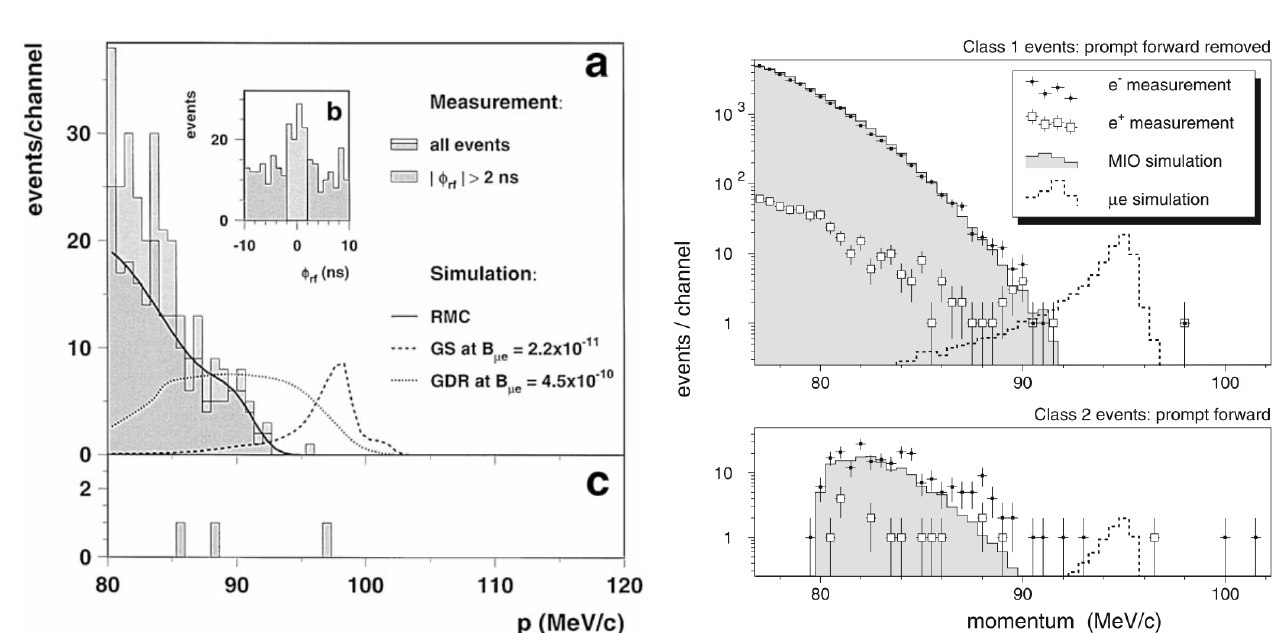
Figure 3. The energy spectrum of the signal estimation and backgrounds of µ − → e + ( left ) and µ − → e − ( right ) from the SINDRUM II experiment[25,41]. For µ − → e + , the upper (a and b) and lower (c) plots are the data when the muon beam is on and off, respectively. Plot (b) shows the decay time distribution relative to the 50.63 MHz beam arrival time, where beam-related electron backgrounds are associated with the beam arrival at 0 ns. The light gray data in plot (a) shows all of the data and the dark gray data is after vetoing these events associated in time with the beam pulse. For µ − → e − , the upper and lower plots are the data with the radiative pion background candidates removed and enhanced,